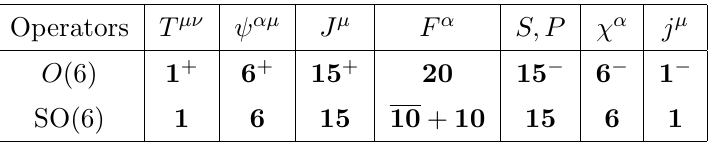
Table 8 . O (6) and SO(6) assignments for operators in the stress-tensor